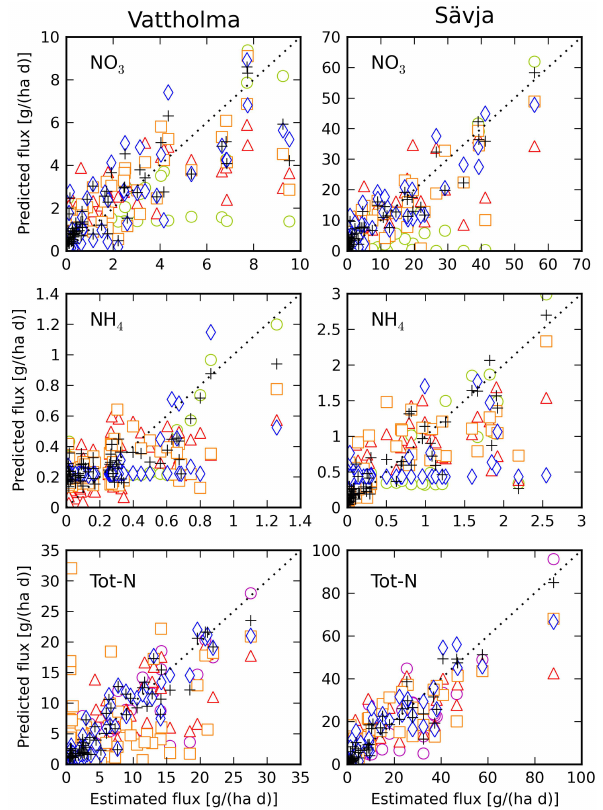
Fig. 5. Estimated daily nitrogen loads (x-axes, in g/had − 1 ) against different prediction from the best SMEs (y-axes, in g/had − 1 ): CHIMP (green circles), HBV-N-D (magenta circles), LASCAM (red triangles), LASCAM-S (orange squares), SWAT (blue dia- monds). Crosses represent the prediction of the best MME for each N species at each station. Corresponding criteria are summarised in Table